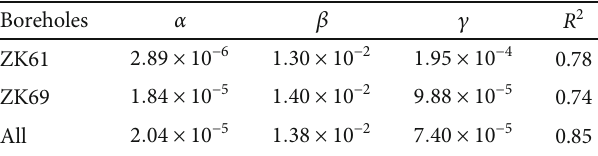
Table 2: Fitting results of CA model parameters.